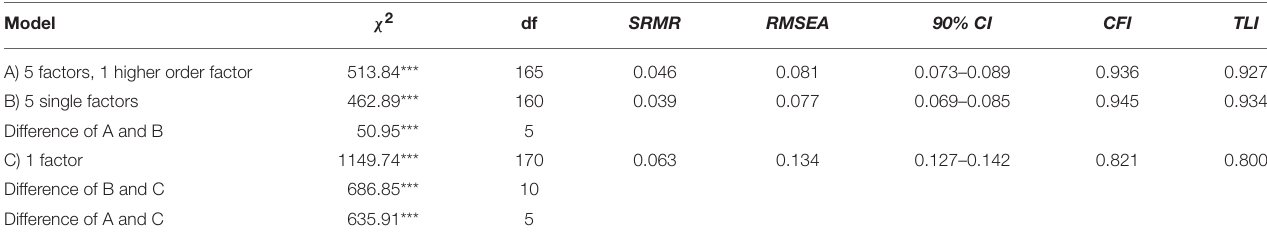
TABLE 1 | Fit Indices of the specified structural models.